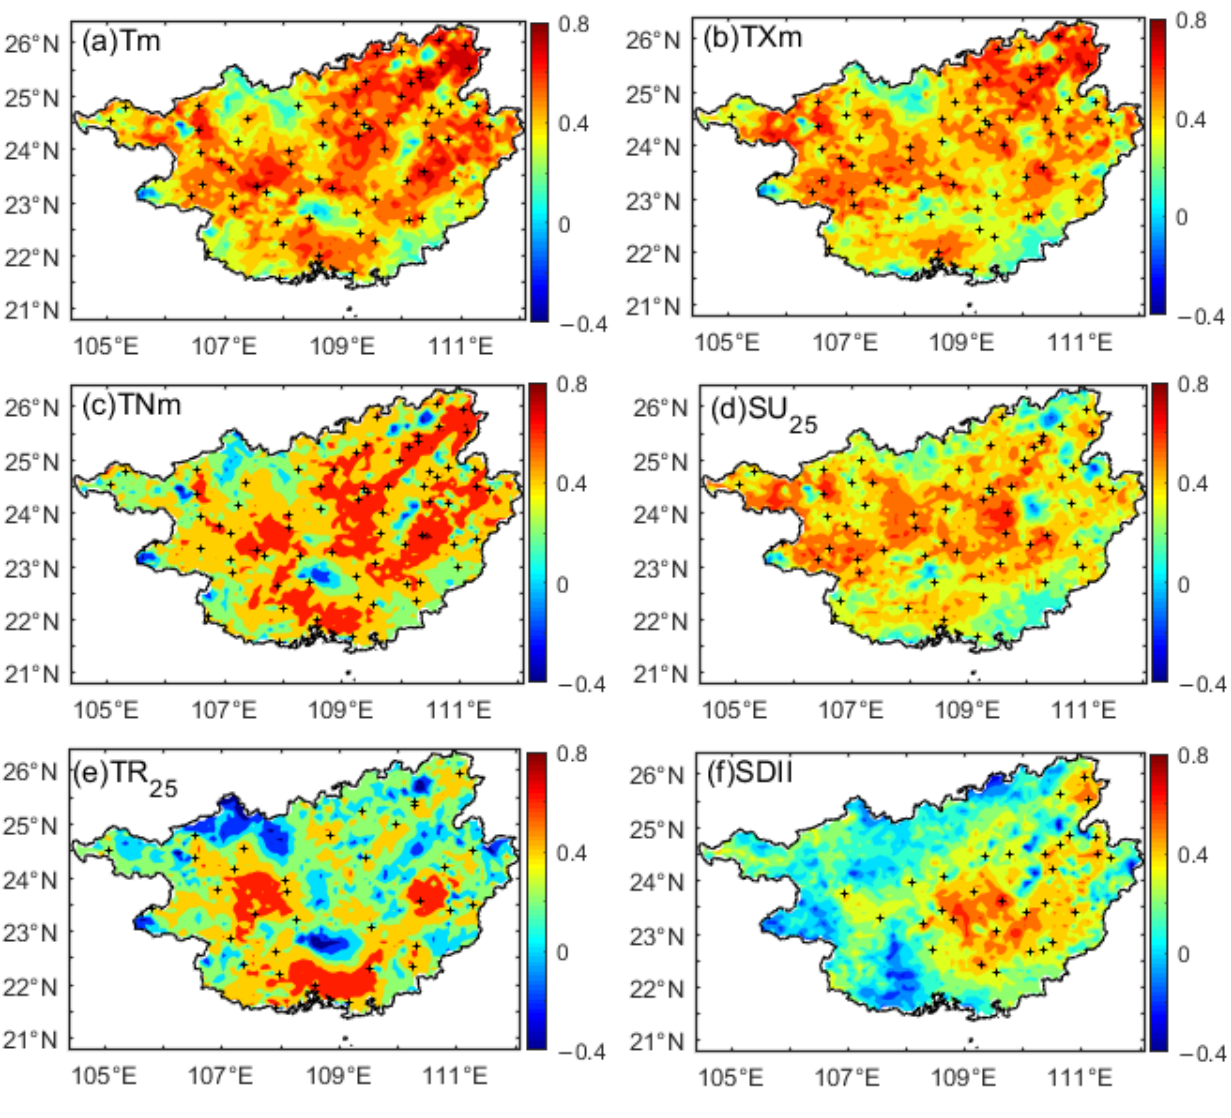
Figure 6. Spatial distributions of the correlation coefficients between the annual NDVI and each temperature extreme index during 1982–2015: ( a ) Tm; ( b ) TXm; ( c ) TNm; ( d ) SU 25 ; ( e ) TR 25 and ( f ) SDII. Note: ‘+’ significant at p < 0.05.